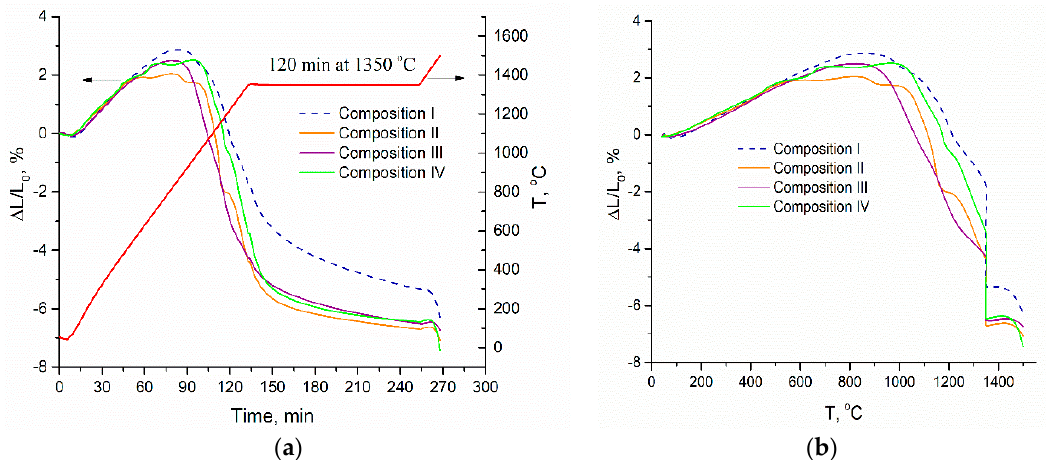
Figure 3. Sintering curves of 3Y-TZP-Al 2 O 3 for Compositions I–IV with continuous heating and isothermal exposure at 1350 °C. Shrinkage is plotted vs. time together with heating profile ( a ) and vs. temperature ( b ).